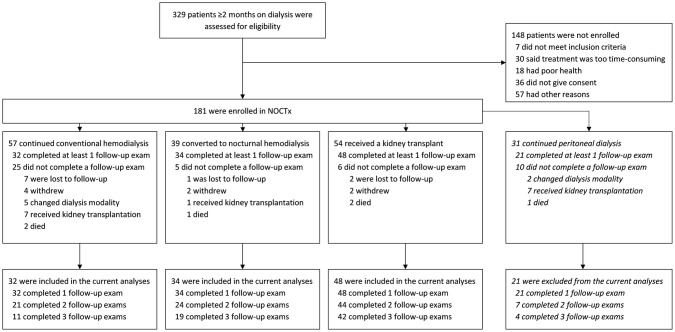
Study flowchart.